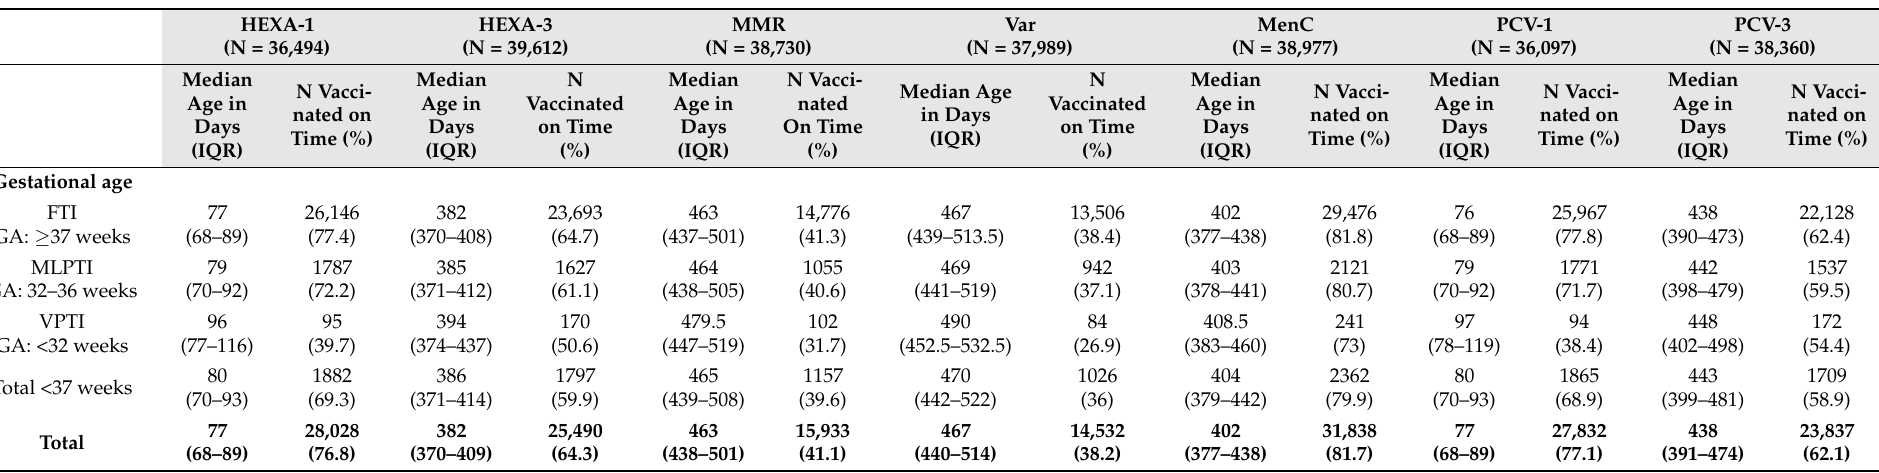
Table 2. Data on age at vaccination (median age and interquartile range—IQR) and timeliness of vaccination for prematurity classes (very preterm infants—VPTI; moderate and late preterm infants—MLPTI; full-term infants—FTI).